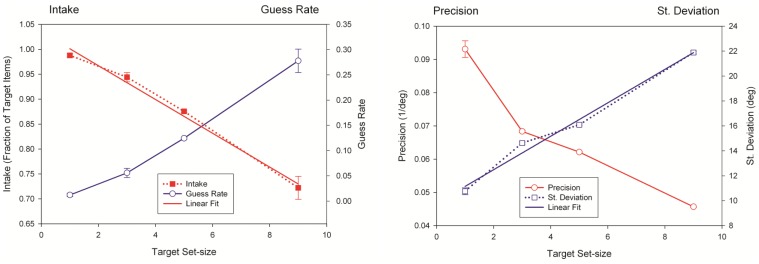
Precision (A) and intake (B) as a function of target set-size.Also included in the plots are guess rate (1-w) and standard deviation (σ). Note that the left and right y-axes have different offsets and scales. Data points correspond to the mean across observers (N = 4) and error bars represent ±1 SEM.